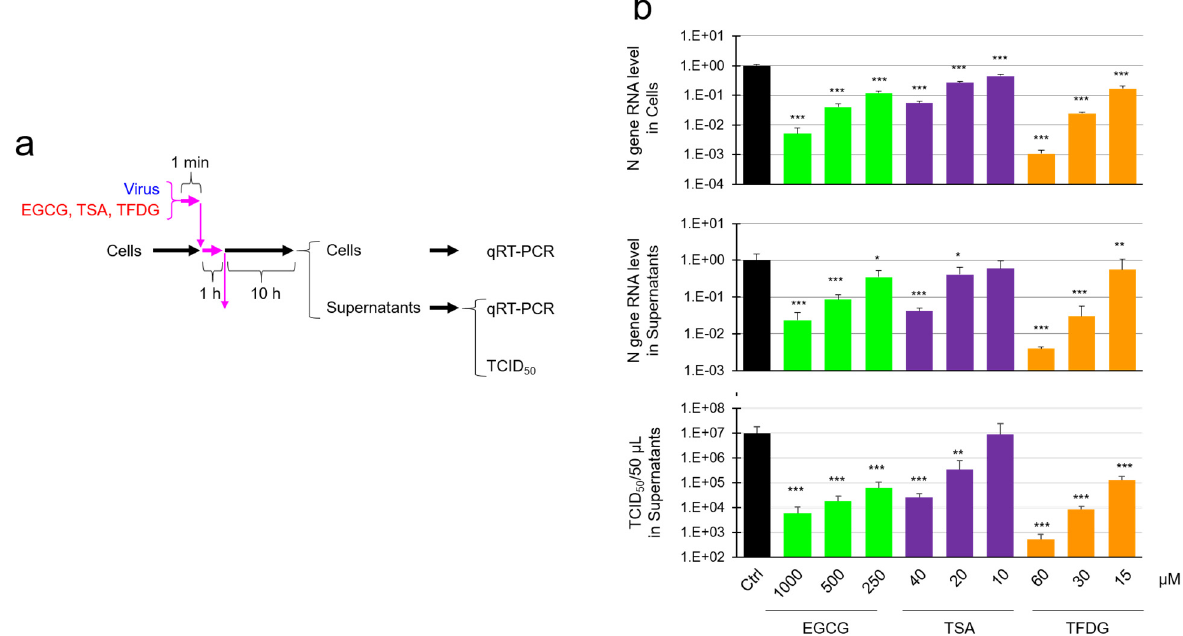
Figure 5. Evaluation of viral RNA in the supernatants and the cells infected with EGCG-, TSA-, or TFDG-treated virus. Virus was treated with the indicated compounds for 1 min, and the mixture was added to VeroE6/TMPRSS2 cells at MOI = 5 for 1 h. After removal of the supernatant, cells were washed with PBS and cultured in fresh MS for 10 h ( a ). RNA was extracted from the supernatants and cells, and real time-RT-PCR was performed as described in the Materials and Methods section. The culture supernatants were also subjected to TCID 50 assay. Means ± S.D. of relative RNA levels and TCID 50 values are shown ( n = 4) ( b ). * p < 0.05, ** p < 0.01, and *** p < 0.001 vs. Control by Tukey’s multiple comparison test.